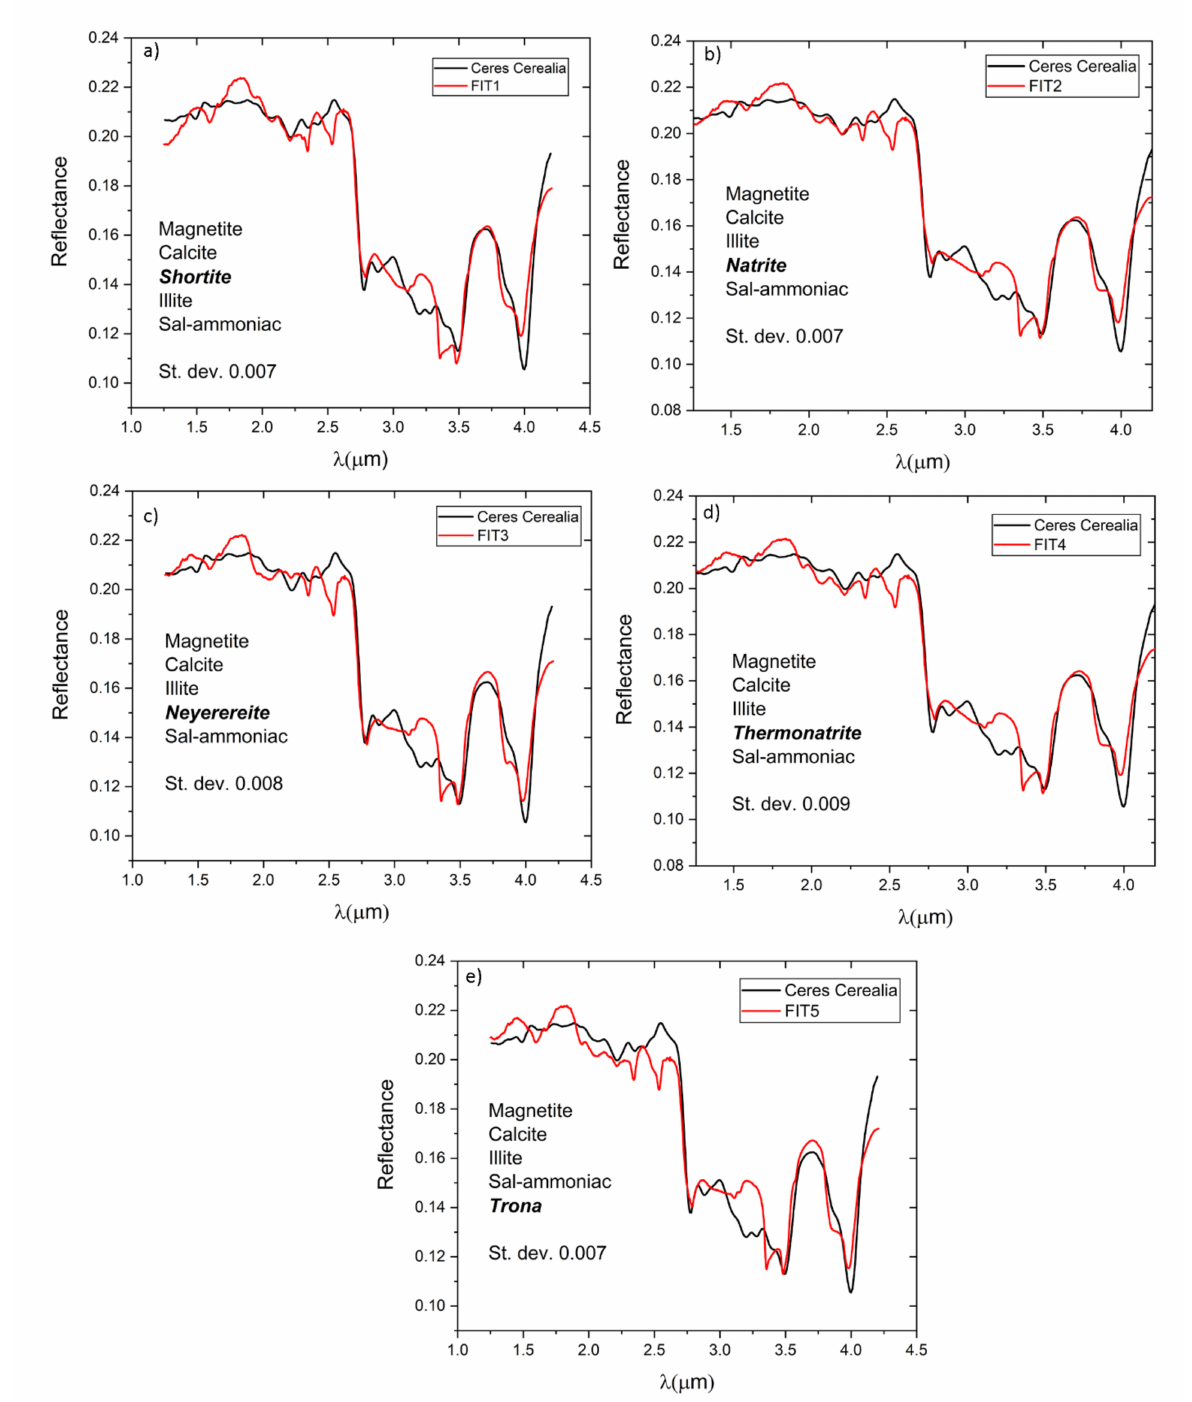
Figure 15. Results of the fitting of Ceres Ceralia (black line) spectra with different mineral mixtures by using Mixture Fit tool (red line): The mixtures are: ( a ) magnetite, calcite, shortite, illite, and sal-ammonica; ( b ) magnetite, calcite, illite, natrite, and sal-ammoniac; ( c ) magnetite, calcite, illite, neyerereite, sal-ammoniac; ( d ) magnetite, calcite, illite, thermonatrite, sal-ammoniac; ( e ) magnesite, calcite, illite, sal-ammoniac, trona. Values of the St. dev. for each mix are given in the figures. The mineral description and abundance are reported in Tables A1 and